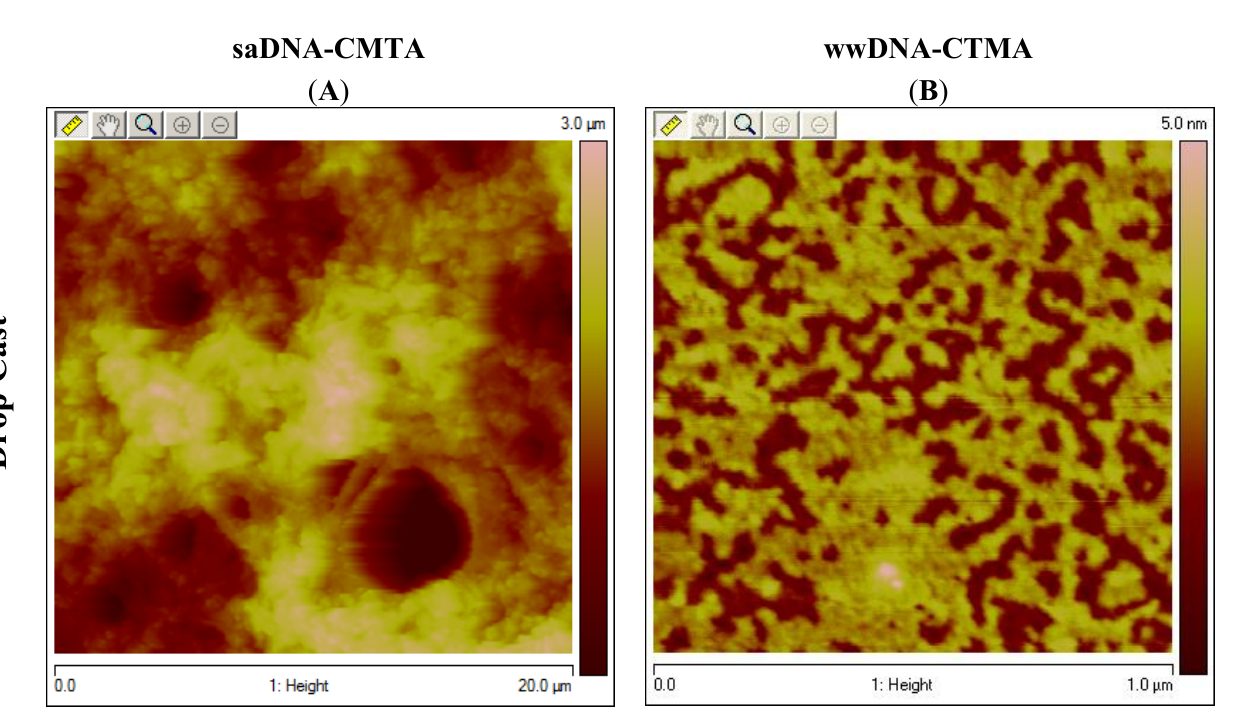
Figure 4. Salmon sperm DNA-CTMA (saDNA-CTMA) and wwDNA-CTMA complex were either drop cast or spin onto freshly cleaved mica and imaged via